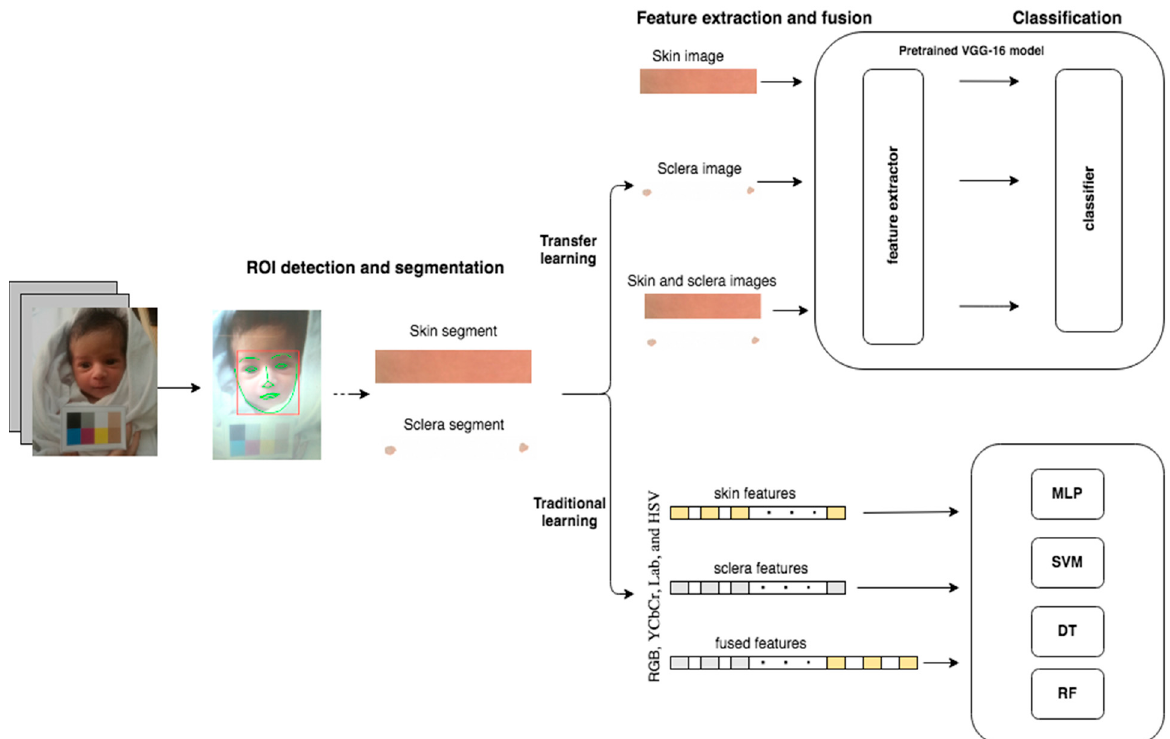
Figure 1. Illustration of the method. Forehead skin and eyes’ sclera regions are detected and segmented from the preprocessed images. The segmented skin, sclera, or skin and sclera images are then passed to (1) transfer learning using a pretrained VGG-16 model for feature extraction and classification and (2) traditional learning to extract RGB, YCbCr, Lab color space, and HSV color space features and then to multi-layer perceptron (MLP), support vector machine (SVM), Decision tree (DT), and random forest (RF) for classification.